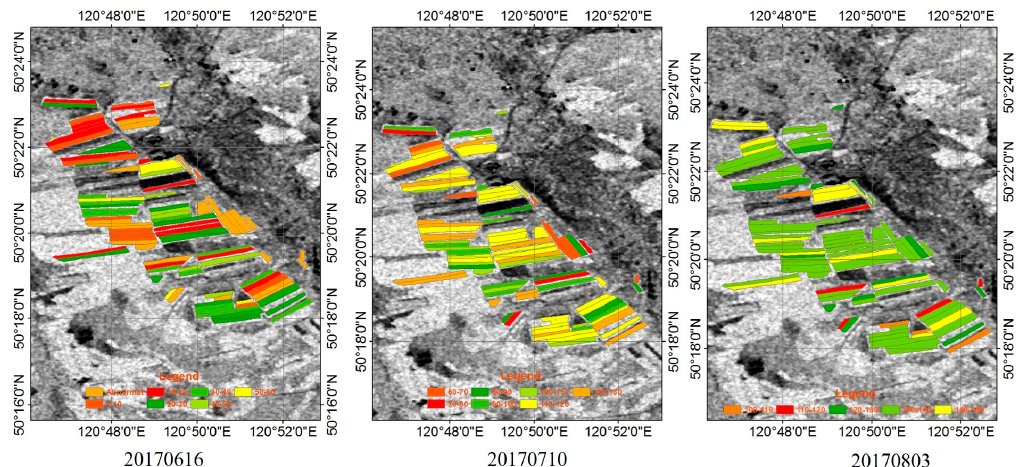
Figure 8. Stem height in 95 rape plots with the background image of scattering angle alpha ( α ). 20170616 is the estimation result of P2, 20170710 is the estimation result of P3, and 20170803 is the estimation result of P4. All of the results were estimated by y = 0.1306x 2 − 3.7836x + 22.944 with α . Table 11 . Proportion of plots within each estimation error range for stem height at each stage.